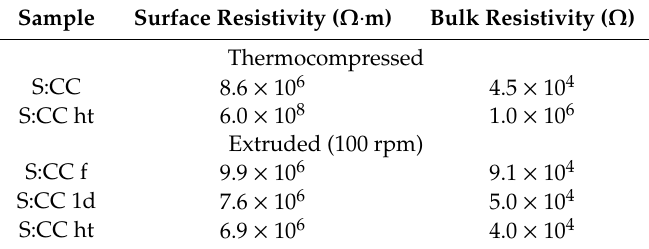
Table 5. Surface and bulk resistivity of TPS / S:CC 2:1 films.